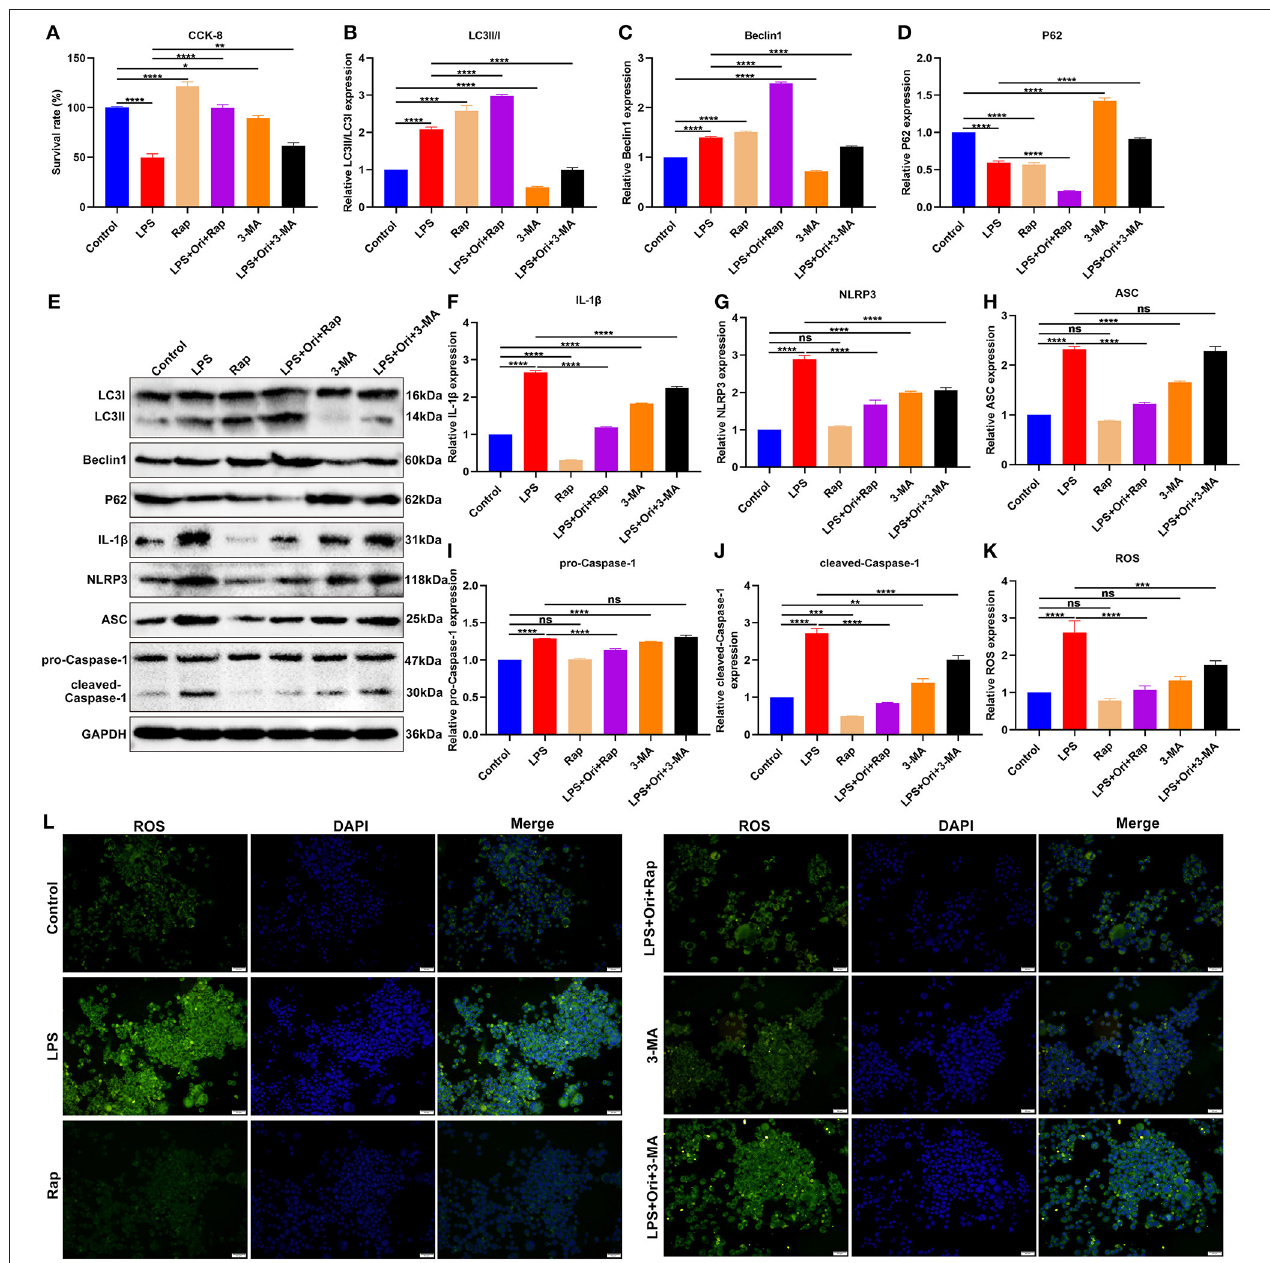
FIGURE 7 | Effects of Ori, autophagy agonist Rap, and autophagy inhibitor 3-MA on NLRP3 inflammasome activation and ROS accumulation in LPS-treated astrocytes. (A) CCK-8 detecting the viability of astrocytes in each group. (B–E) Western blotting examining the expression autophagy markers LC3II/I, Beclin1 and P62 in astrocytes. (F–J) Western blotting testing the levels of NLRP3 inflammasome proteins IL-1 β , NLRP3, ASC, pro-Caspase-1 as well as cleaved-Caspase-1 in astrocytes. (K) Quantitative analysis of the expression of ROS based on the H2DCF-DA fluorescence staining results. (L) Representative H2DCF-DA fluorescence staining of ROS in astrocytes. Magnification, 200 × (50 µ m). N = 3 each group. P values were calculated with ANOVA followed by Turkey’s post-hoc test. Ns, not significant; * p < 0.05; ** p < 0.01; *** p < 0.001; **** p <